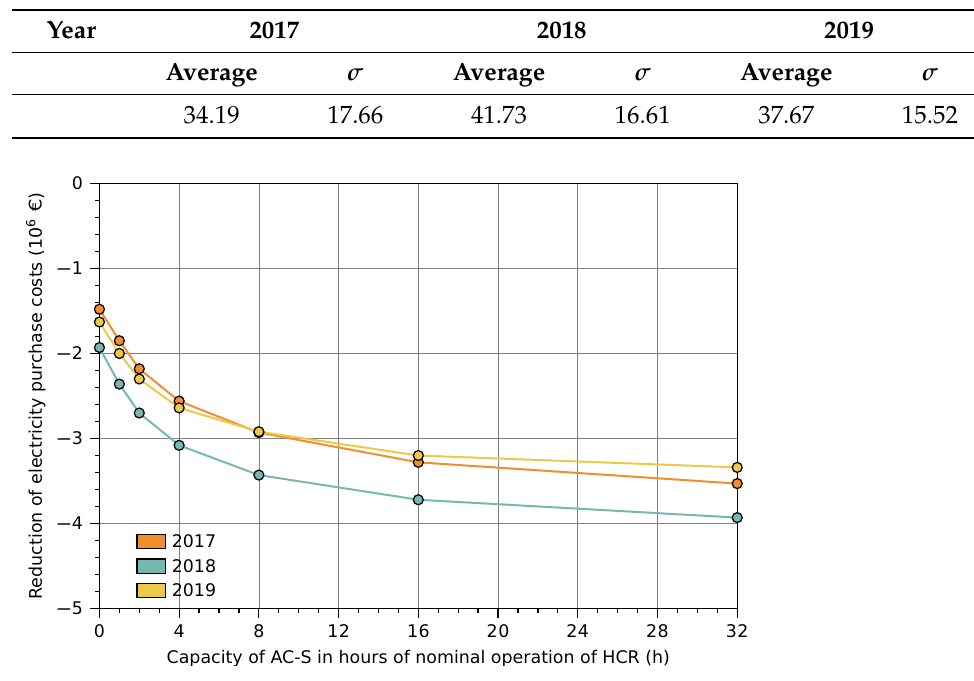
Table 2. Mean yearly price levels given in e /MWh on the spot market including standard deviation σ , database [44].